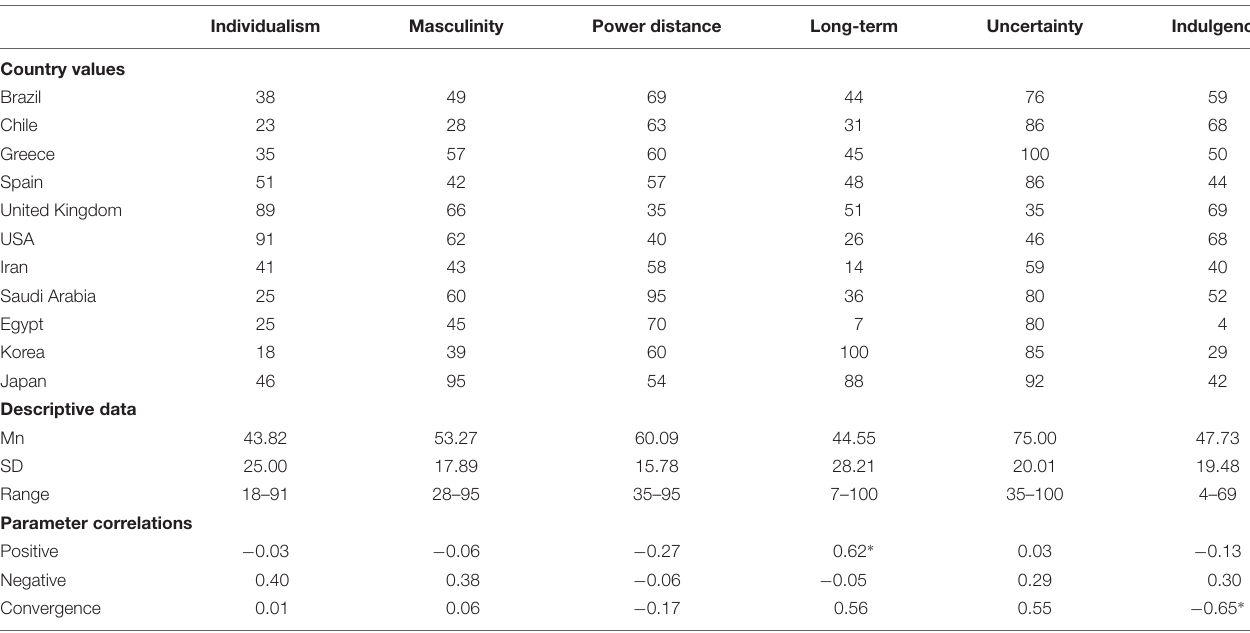
TABLE 6 | Hofstede’s cultural values and relationships with the SCS trait parameters † . Individualism Masculinity Power distance Long-term Uncertainty Indulgence Country